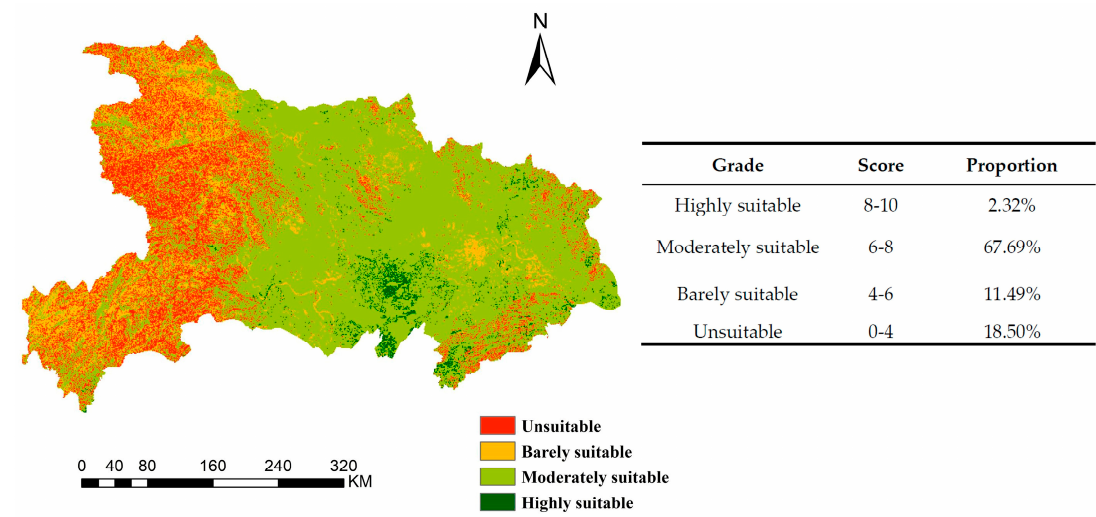
Figure 6. Farmland suitability classes in Hubei Province.